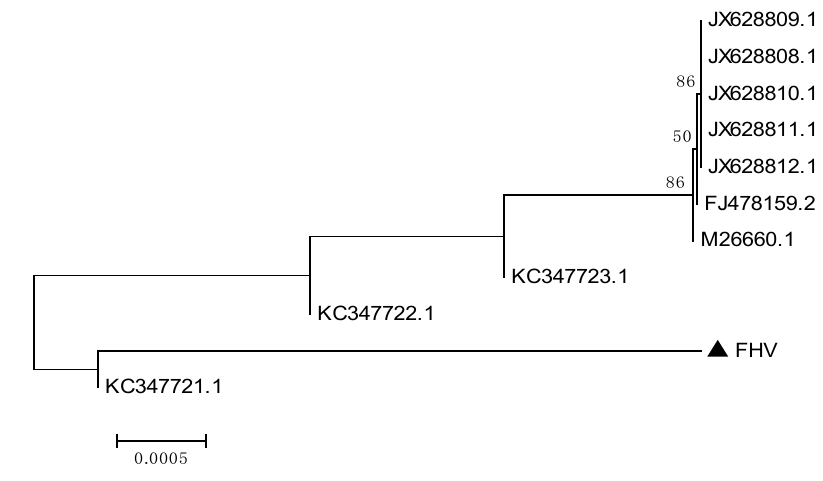
Figure 2. Phylogenetic tree based on the nucleotide sequences of the TK gene. The tree was constructed with MEGA [10]. The isolate of this study is indicated by a solid triangle.